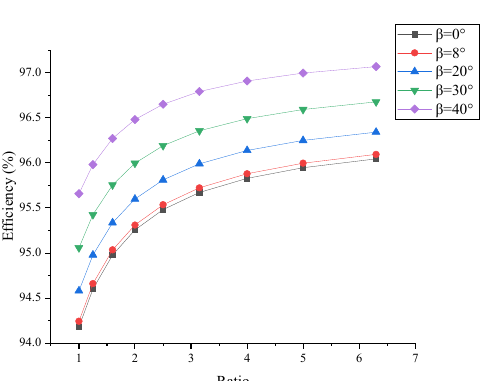
Figure 4. Gear efficiency versus gear ratio for lubricated gears. Table 6. Lookup table for gear ratio and efficiency (without lubrication).